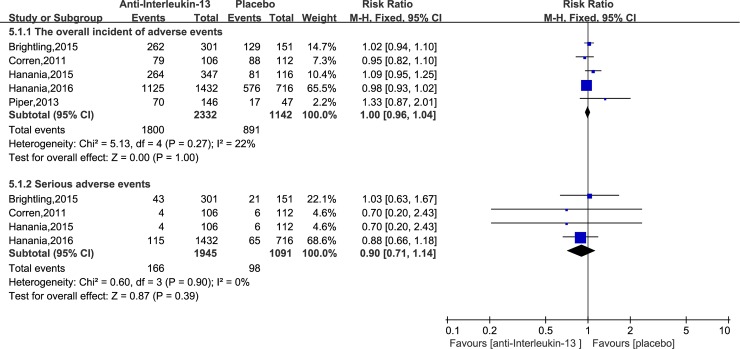
Forest plot comparing anti-IL-13 and placebo with adverse events and serious adverse events.